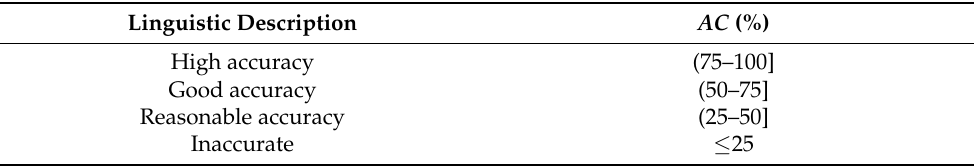
Table 25. Linguistic description of model accuracy for two-state